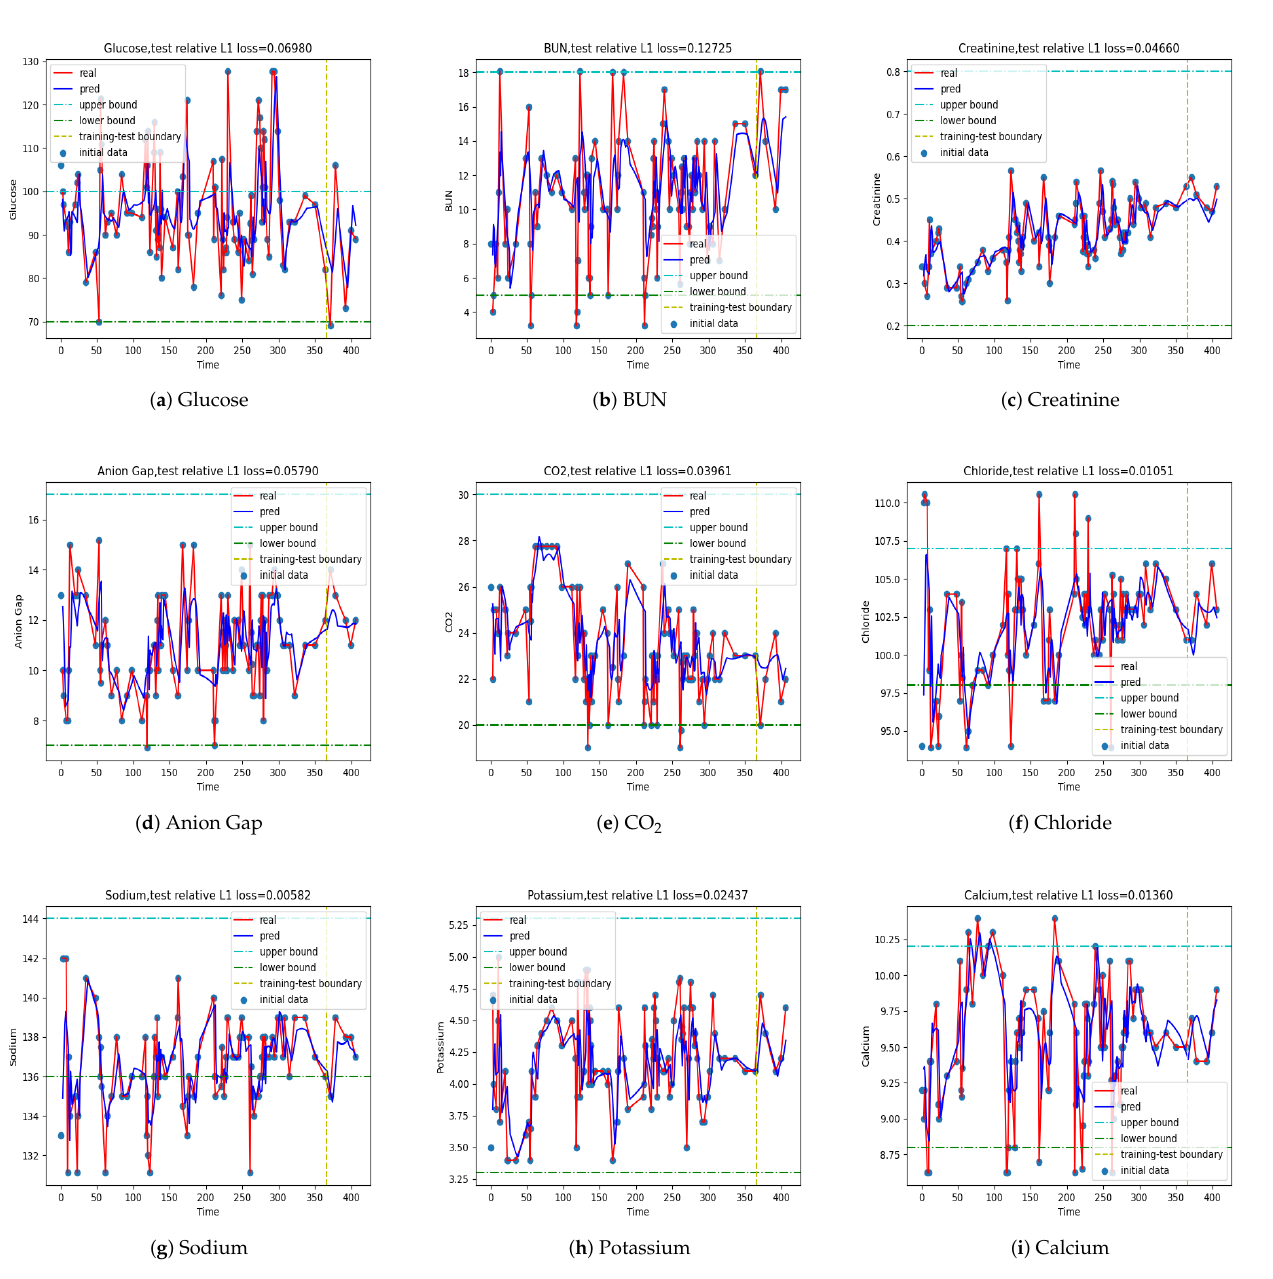
Figure A4. The multistep prediction of the LSTM model for patient PH with T = 1, L =